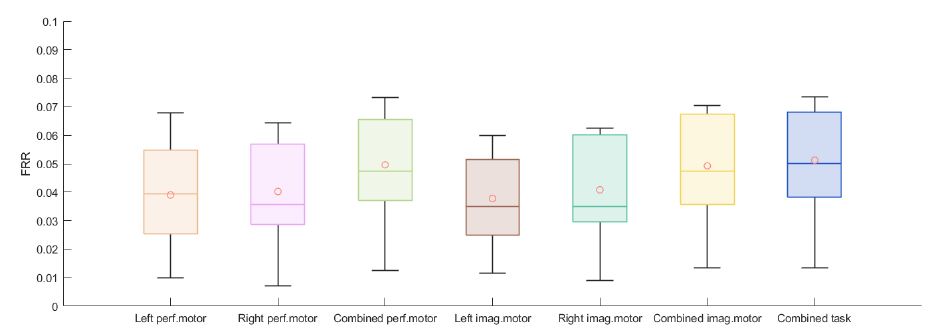
Figure 10. Boxplots of 15 subjects’ averaged FRR for 5-fold cross-validation for left performed motor, right performed motor, combined performed motor, left imagined motor, right imagined motor, combined imagined motor, and combined tasks.